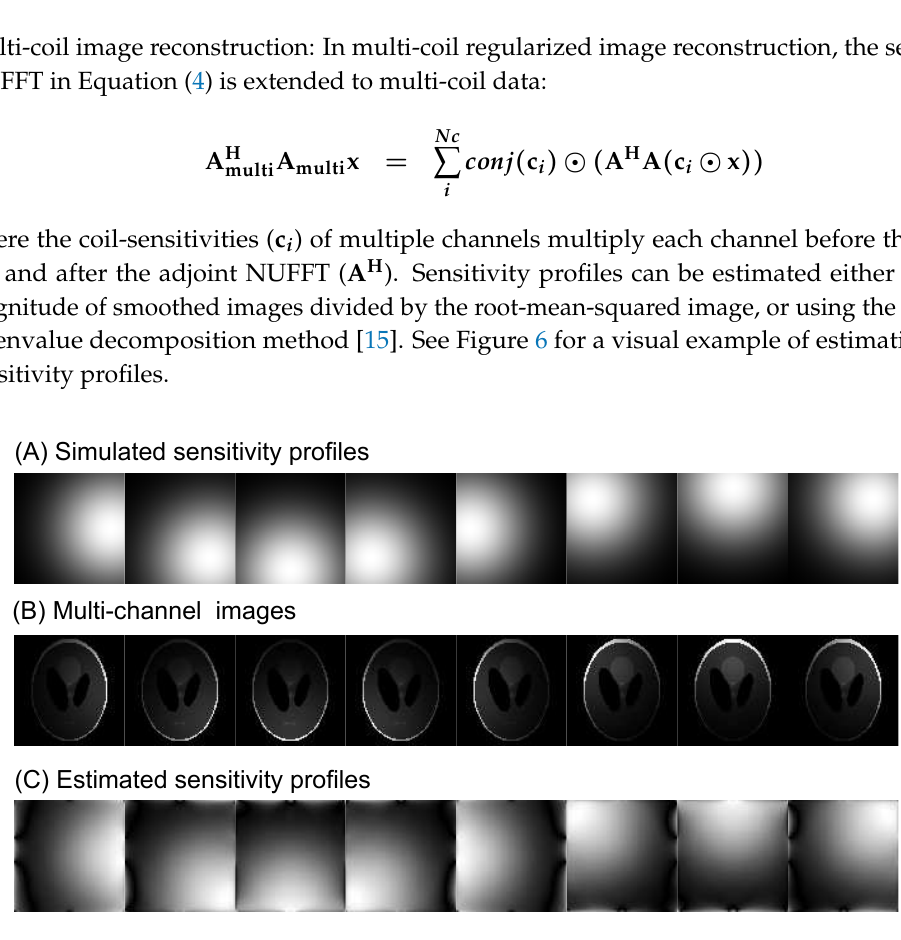
Figure 6. An example of multi-coil sensitivity profiles estimated by the eigenvalue approach [15]. ( A ) Simulated sensitivity profiles. ( B ) Images from multi-channel. ( C ) Sensitivity profiles estimated from ( B